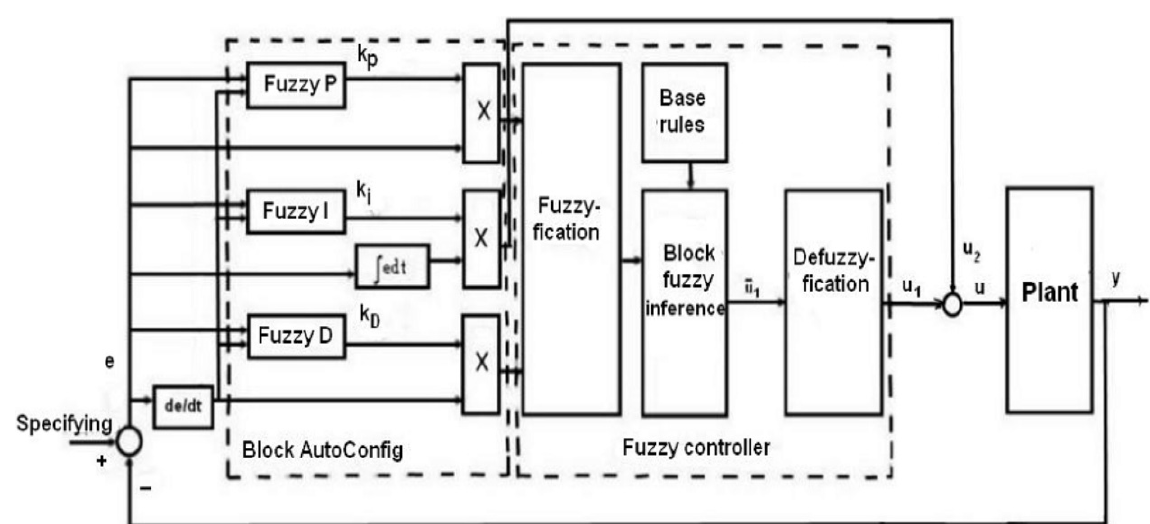
Figure 1. Block diagram of the proposed PID